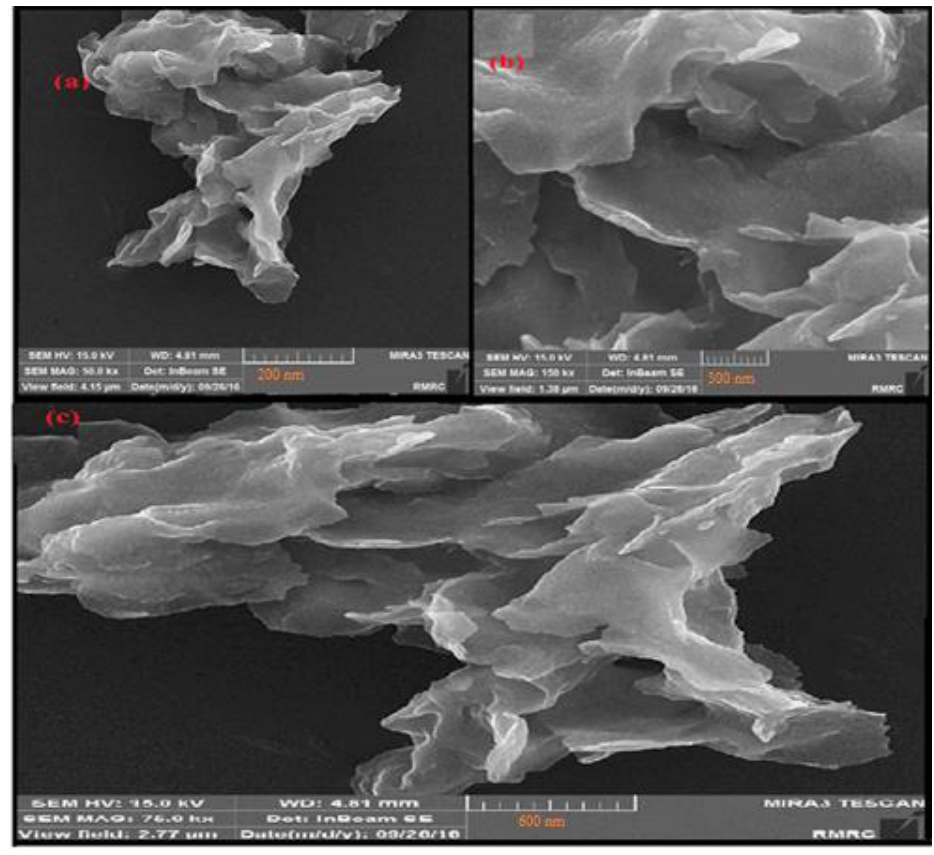
Fig. 3. FESEM images of activated